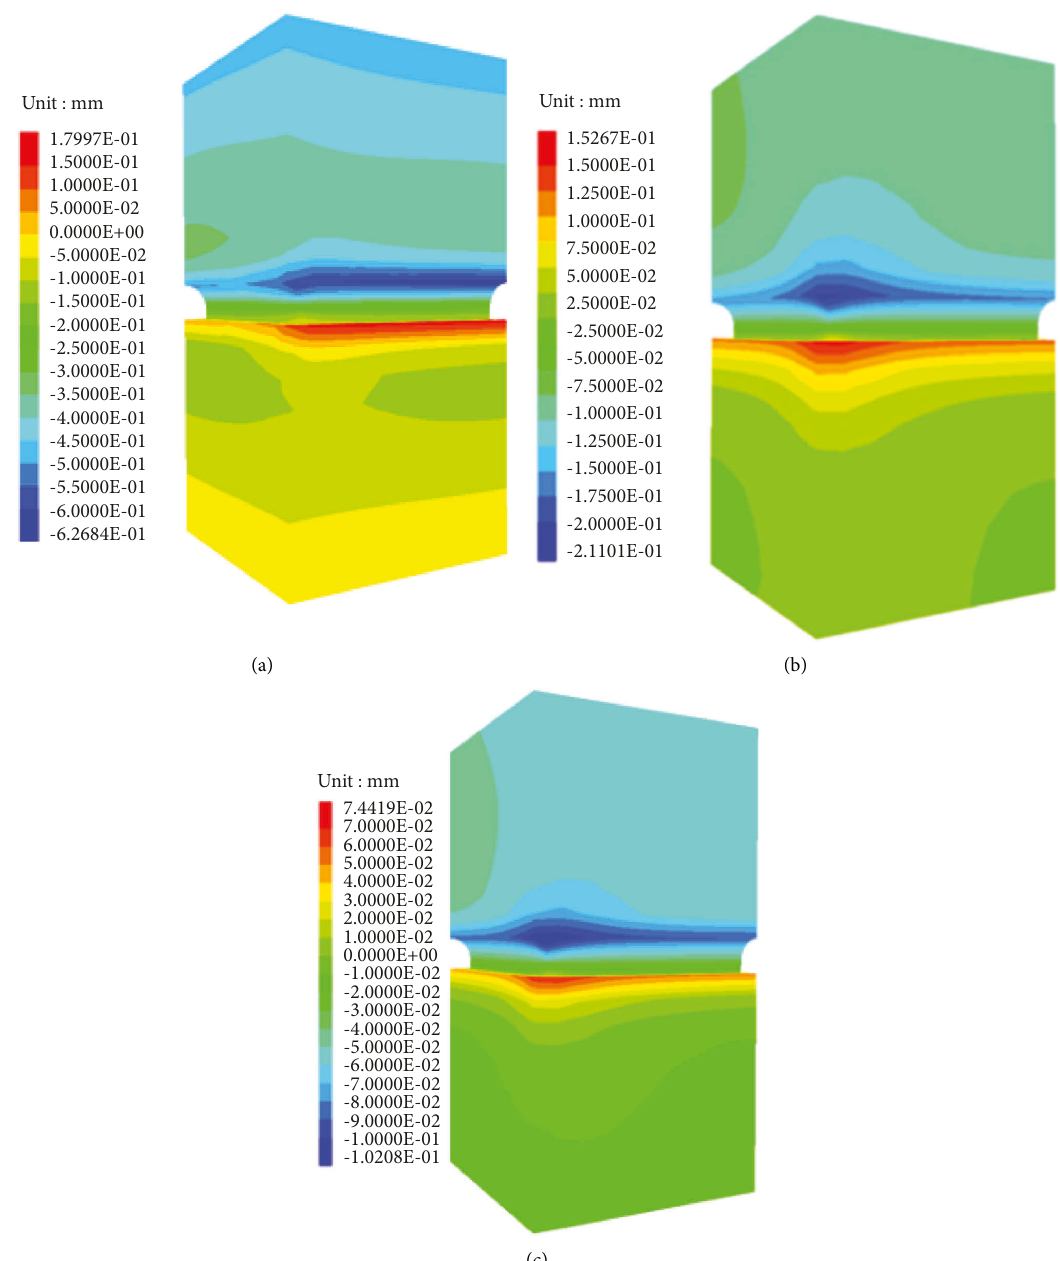
Figure 6: Vertical displacement field, (a) original support system, (b) high prestressed constant resistance coupling support system, (c) dual- control constant-resistance coupling control